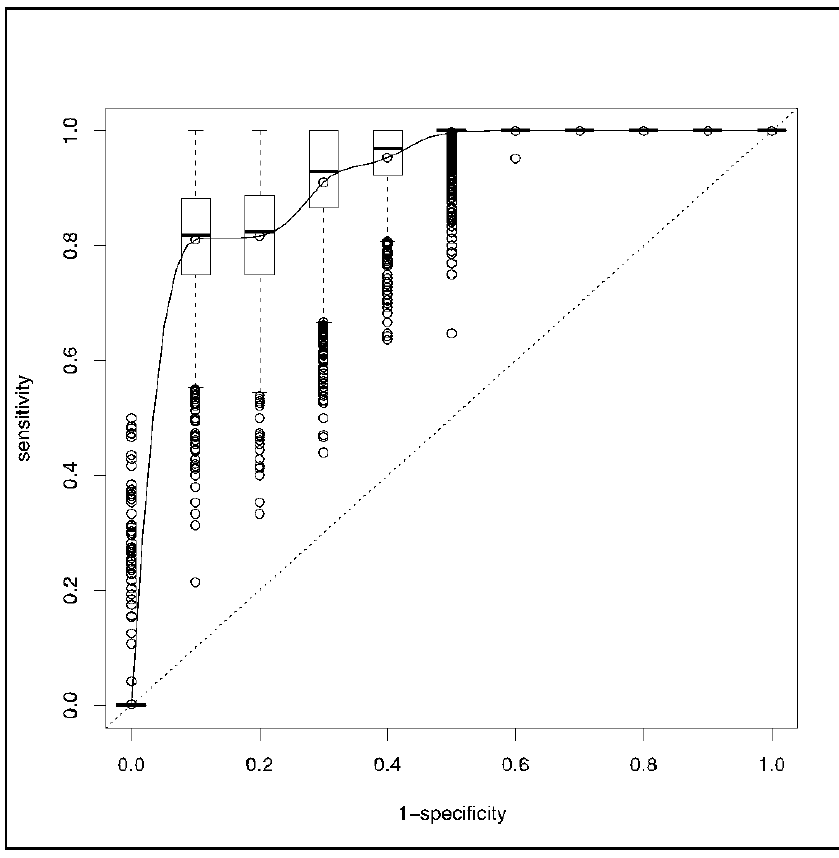
Figure 5. ROC (receiver operating characteristic) curve of the Hypoxemia Index (HI).